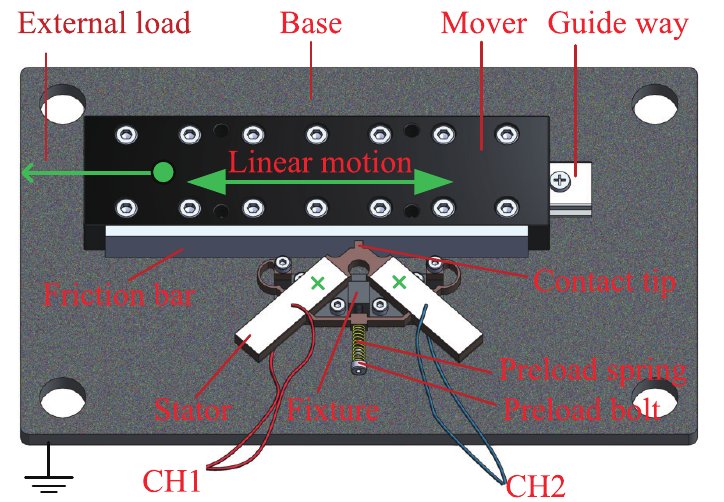
Figure 1. Structure of the LUM